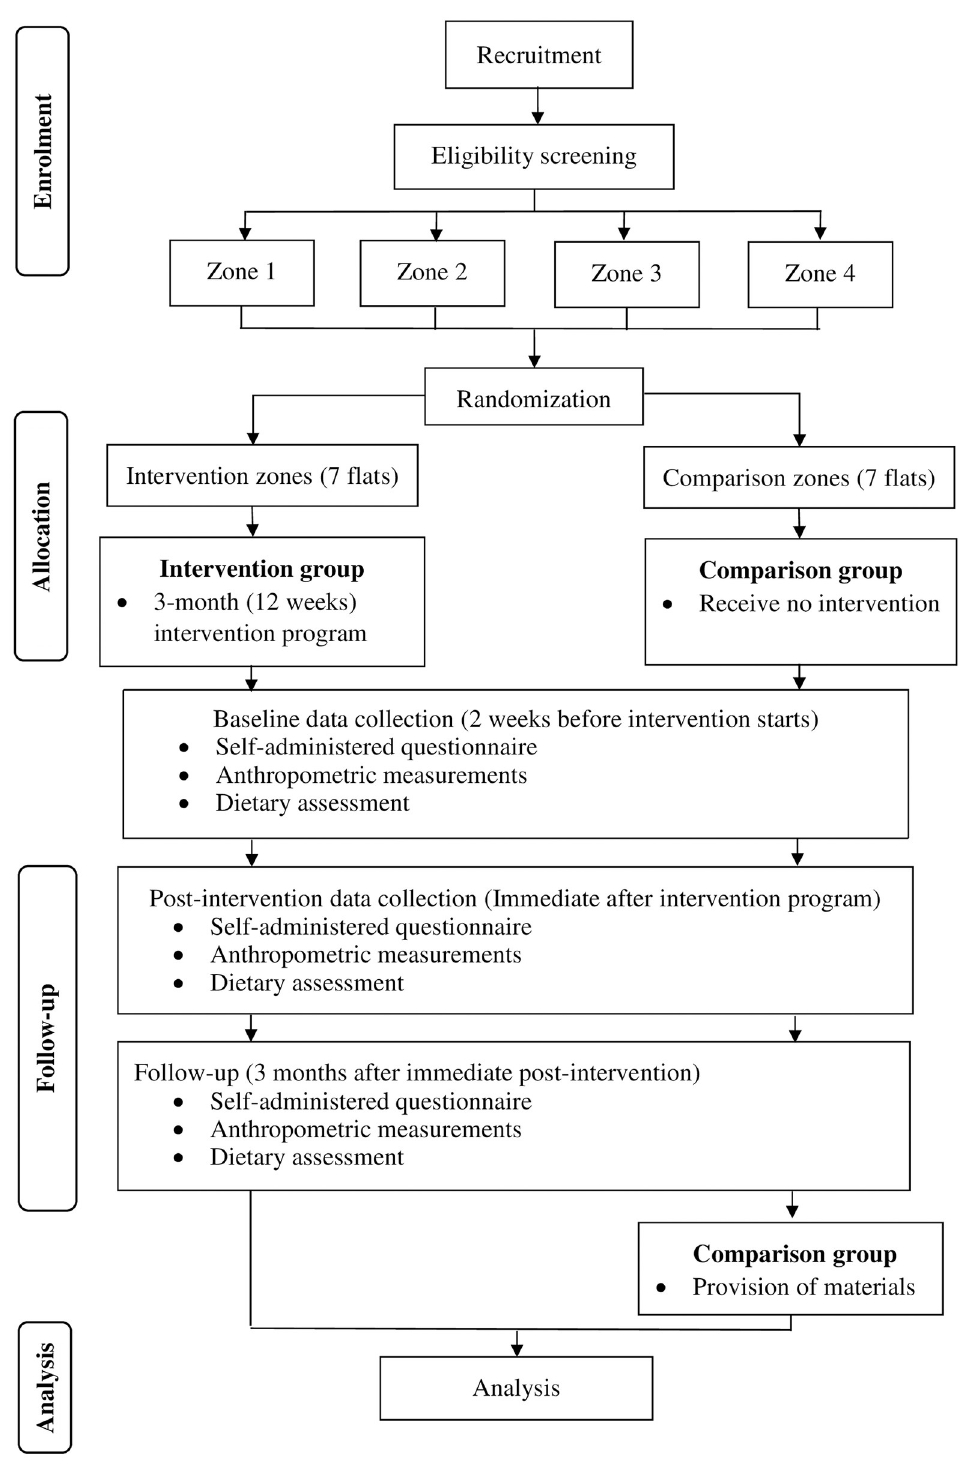
Fig 2. CONSORT diagram of the study